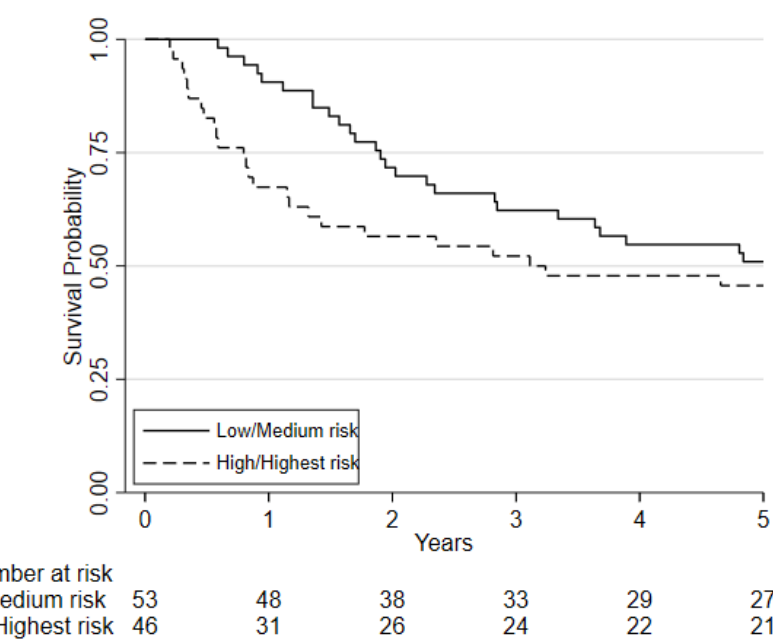
Figure 6. A Kaplan-Meier plot of the estimated overall 5-year survival estimates among patients with oesophageal, esophagogastric-junction and gastric cancer who underwent CPET pre-and post-chemotherapy or chemoradiotherapy (NAC/ CRT) followed by surgery. Patients are split based on their pre-NAC/CRT VO2 at AT using predefined risk stratification categories (low risk Vo2 at AT >14ml.kg.-1min-1, medium risk Vo2 at AT 11.0-14.0ml.kg-1.min-1, high-risk Vo2 at AT 8.0-10.9ml.kg-1.min-1, highest risk Vo2 at AT <8.0ml.kg-1.min-1).